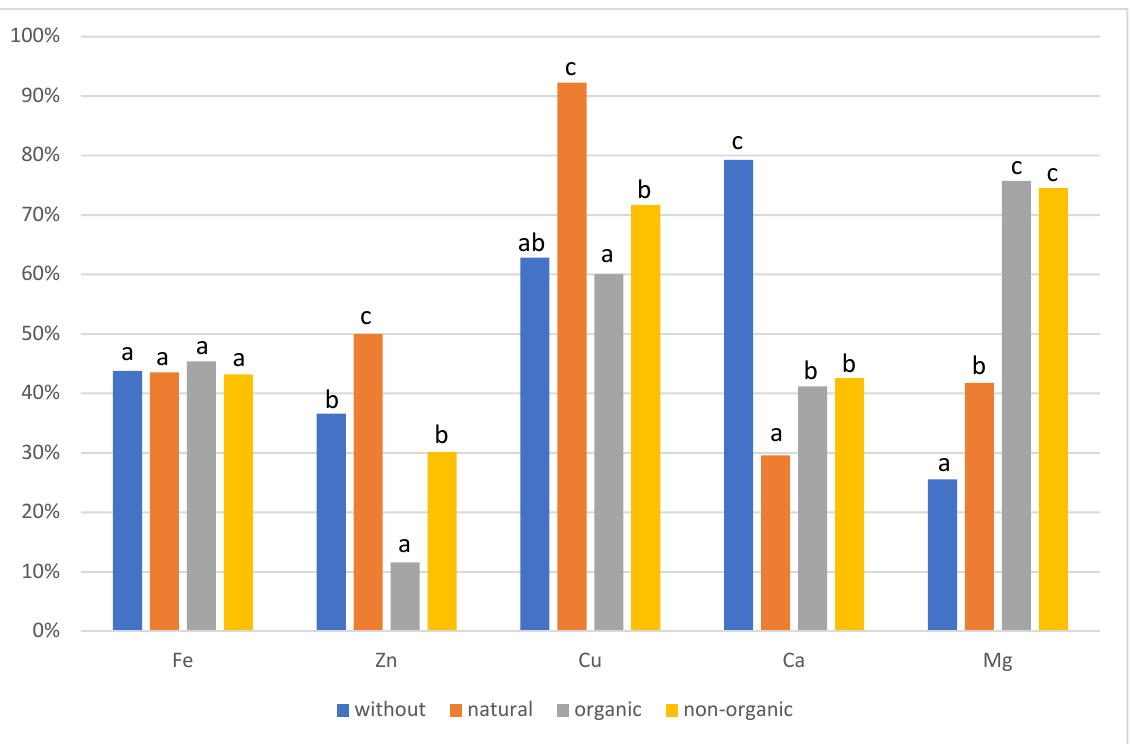
Figure 1. Bioavailability in rice bread, a, b, c statistical differences between additives (seeds, supplements).